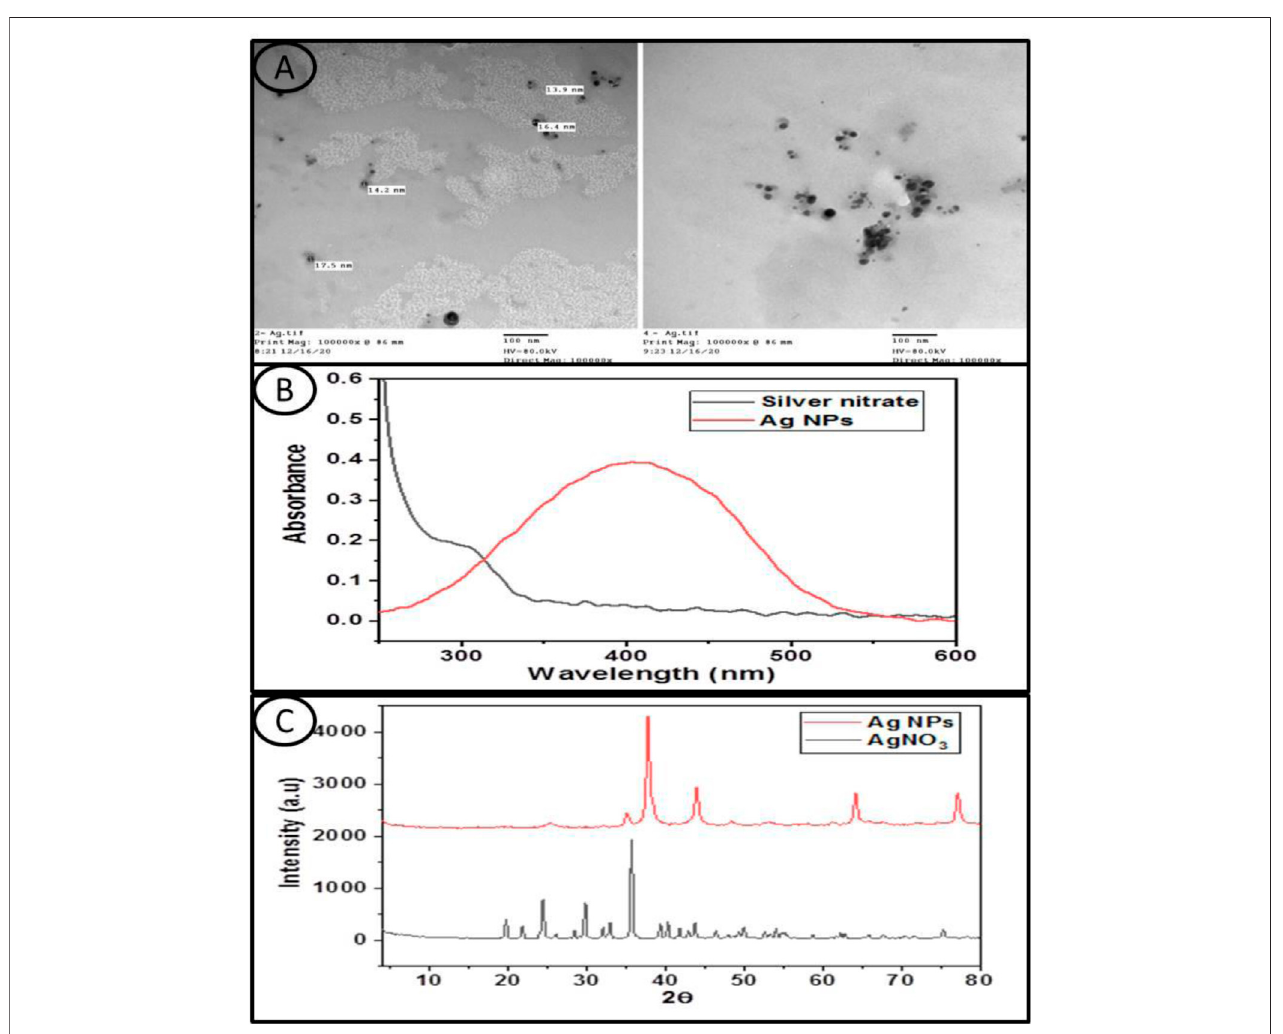
FIGURE1|(A) TransmissionelectronmicroscopeimagesoftheinvestigatedSilverNanoparticles, (B) showstheUV-Visabsorptionspectraofthesilvernitrateand Ag NPs aqueous solution and (C) displayed the XRD patterns of silver nitrate and the Ag NPs used in this study.